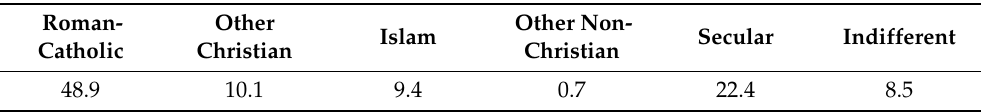
Table 3. Religious self-identification of students in Flemish Catholic schools (primary and sec- ondary) 16